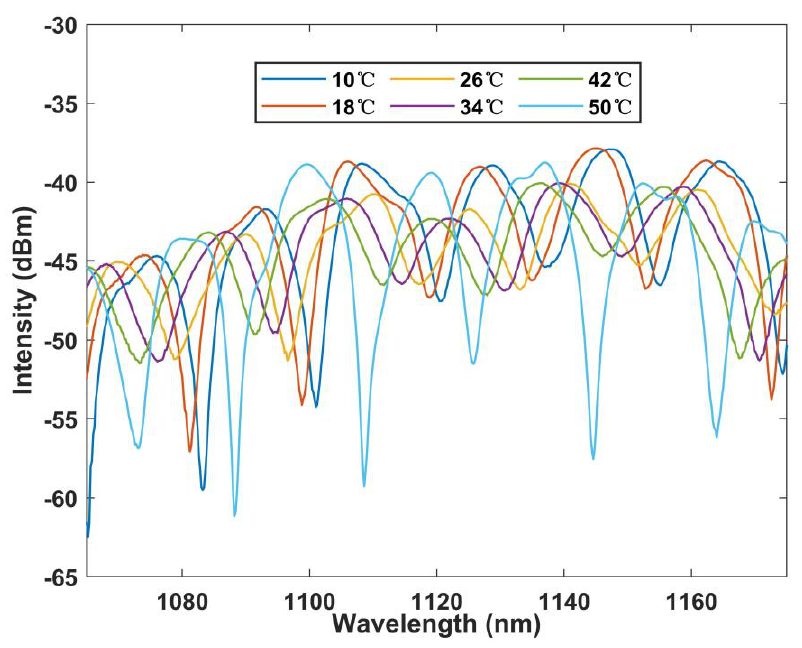
Figure 6. Wavelength versus temperature curve under BBS.